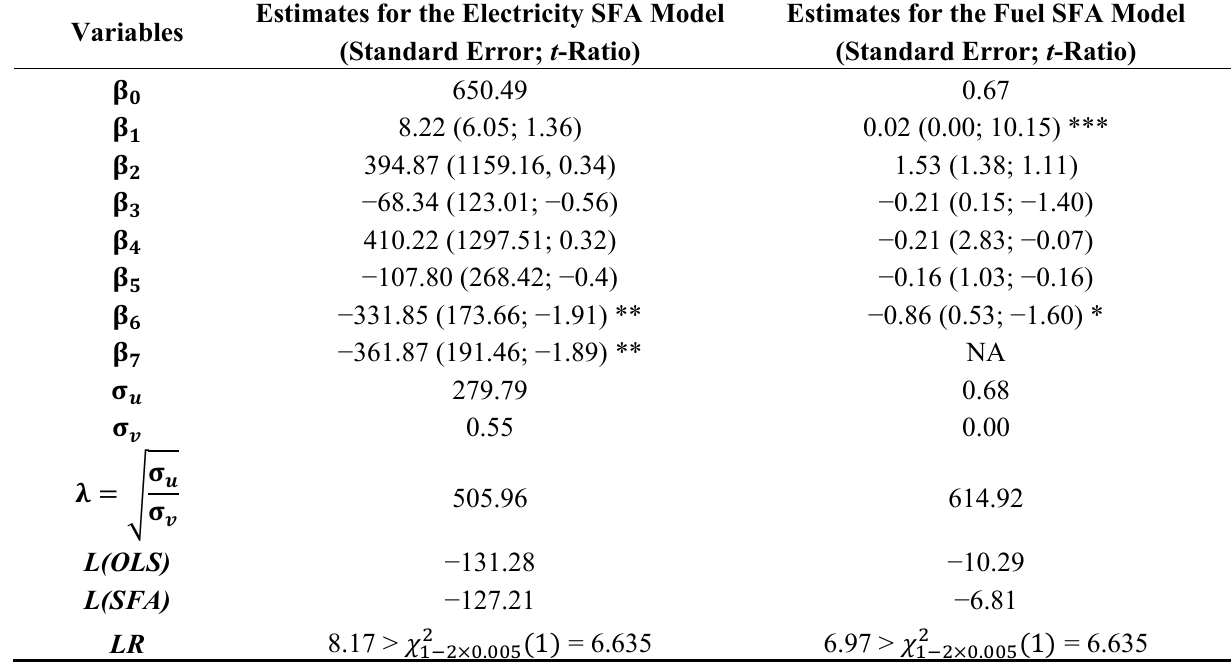
Table 5. Parameter estimates for the SFA models (Notations for significance level in